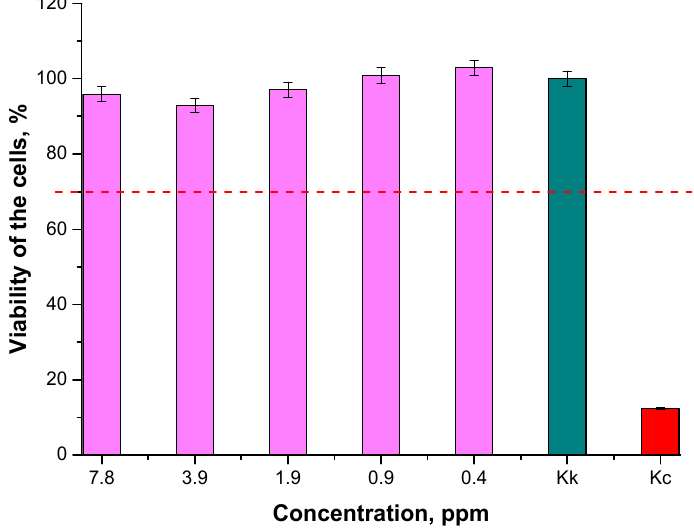
Figure 13. Results of MTT reduction assay of Fe 3 O 4 @Au nanoparticle suspensions prepared in the water environment (the cell viability over 70%—this has been marked via a red dotted line—indicates non-cytotoxicity of tested materials).